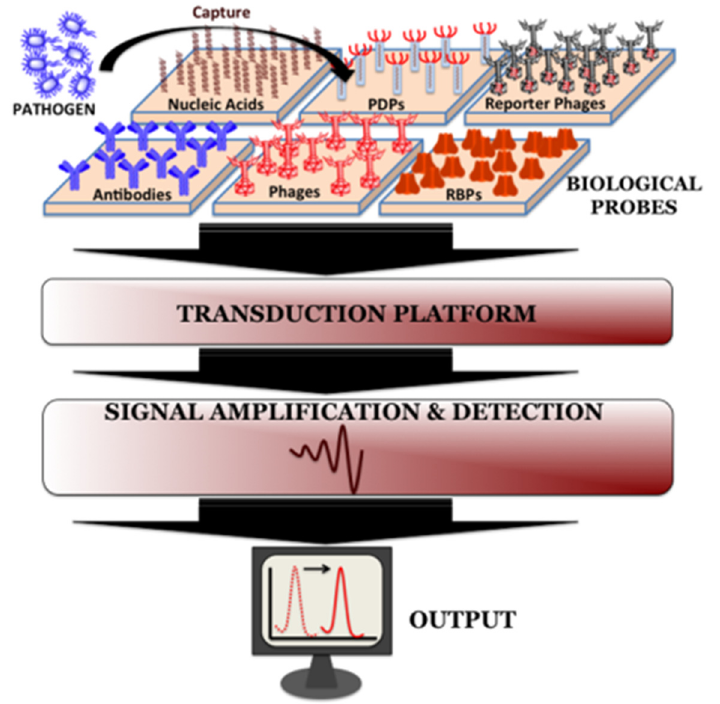
Figure 4. Components of a typical biosensor for pathogen detection, highlighting the currently available phage-based molecular probes. A standard biosensor contains three associated components: (i) a sensor platform, displaying bioprobes that confer specificity of recognition, (ii) a transduction platform, that generates a measurable signal when the bioprobes successfully capture target molecules, (iii) and the amplifier, which enhances and processes the signal in order to provide a quantitative estimate of the target molecules captured. Figure from Singh et al., 2019 [111] (Creative Commons Attribution License).